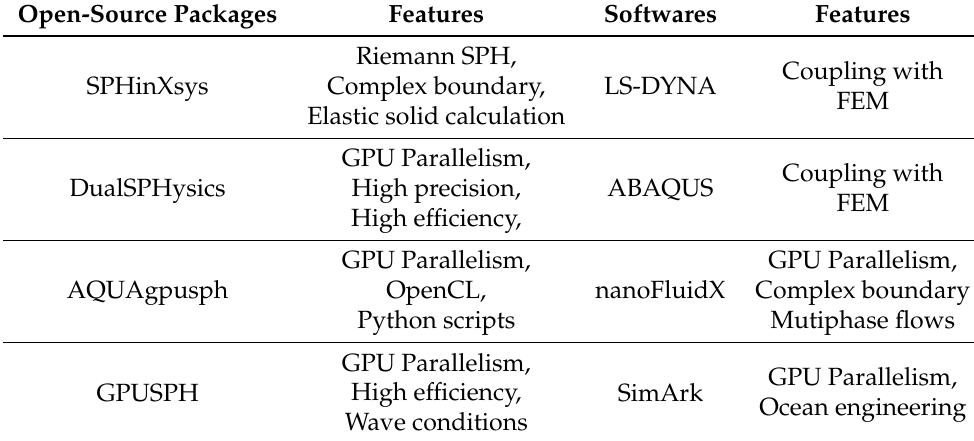
Table 2. Open-source packages and commercial software based on SPH methods. Open-Source